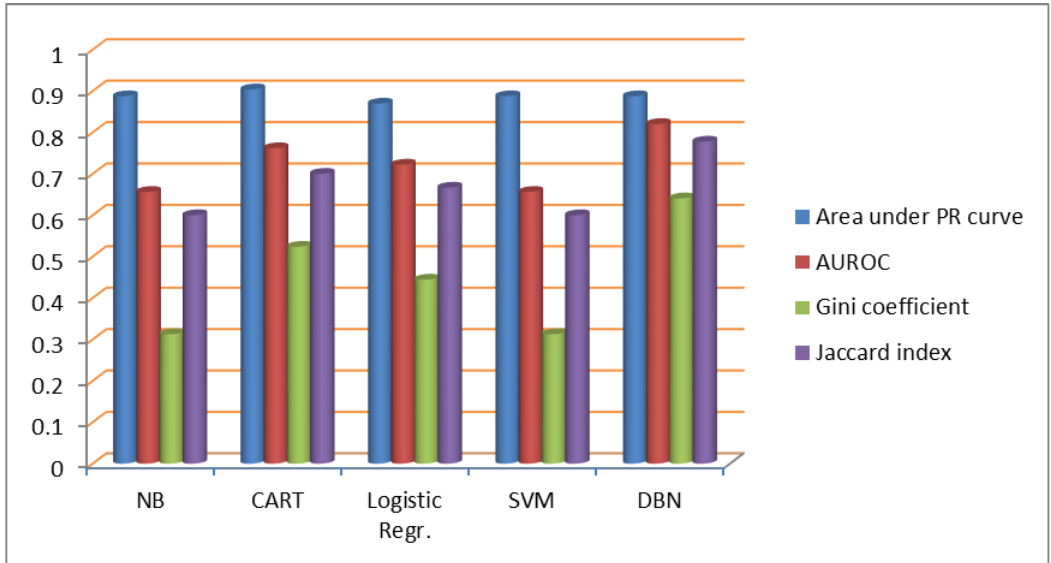
Figure 17. Comparison of results obtained for all algorithms.